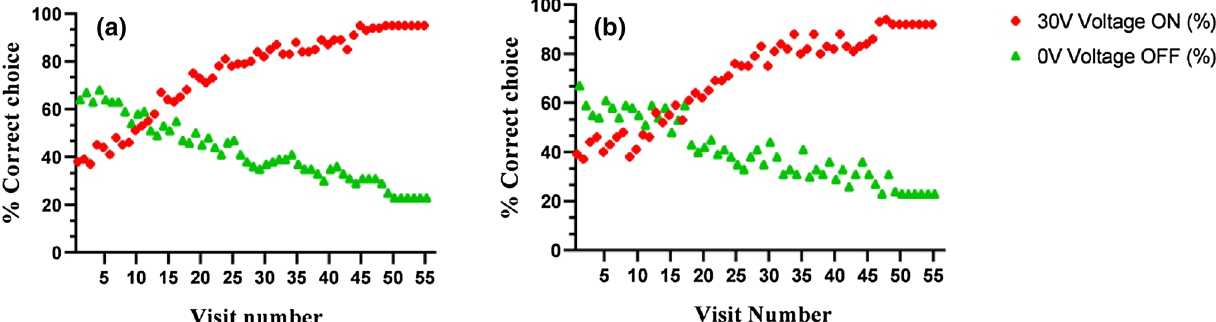
Figure 2. Hoverflies indicates the ability to learn about the presence and absence of an electric field. ( a ) The plot indicates the learning ability of Cheilosia albipila to the electric field at 30 V in red and at 0 V (OFF) control in green. In this case, C. albipila has access to all three types of flowers (+ ,−and 0) at the same time. ( b ) The graph indicates the learning ability of Eristalis tenax to the electric field at 30 V in red and at 0 V (OFF) control in green.